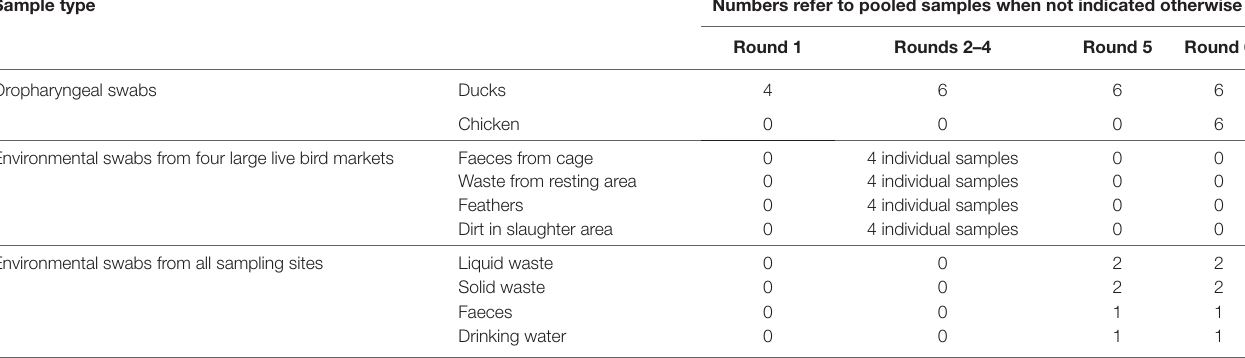
TaBle 2 | Target number of samples to be collected per market day, according to round and sample